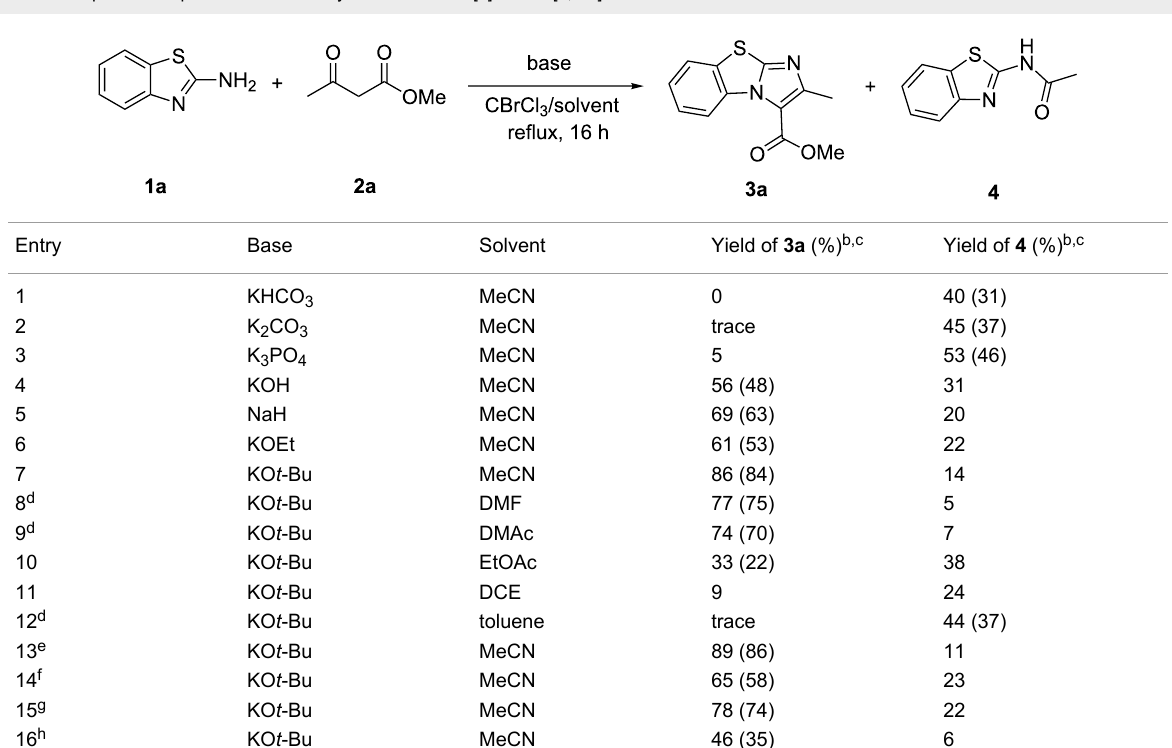
Table 1: Optimization parameters for the synthesis of benzo[ d ]imidazo[2,1- b ]thiazoles 3a .